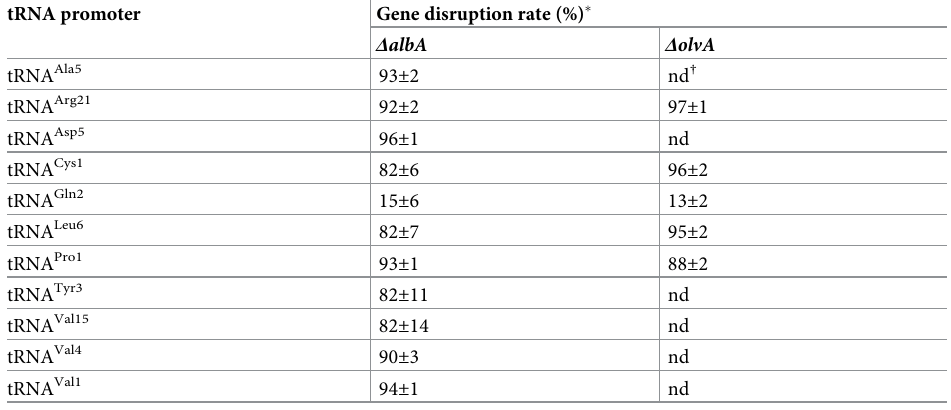
tRNA Val1 94±1 nd (cid:3) The rate was calculated as the percentage of mutant colonies in all transformants. Results were based on triplicate transformations. † nd: not